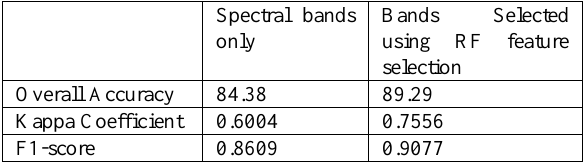
Table 4. Accuracy assessment on test dataset from